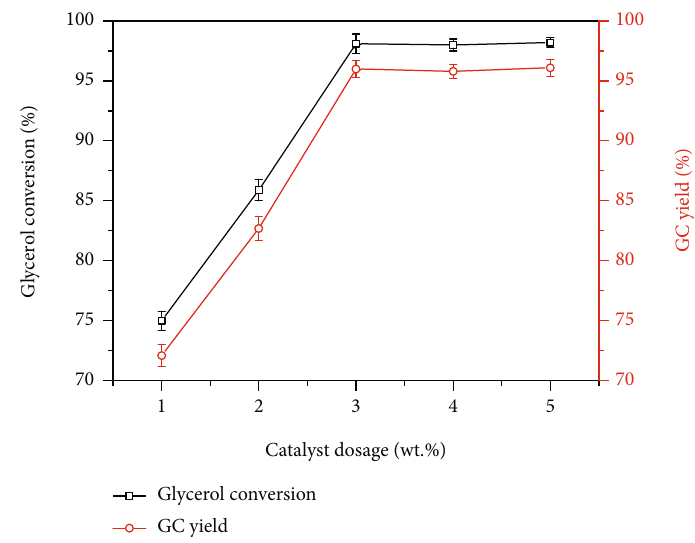
Figure 10: E ff ect of catalyst dosage on glycerol conversion and GC